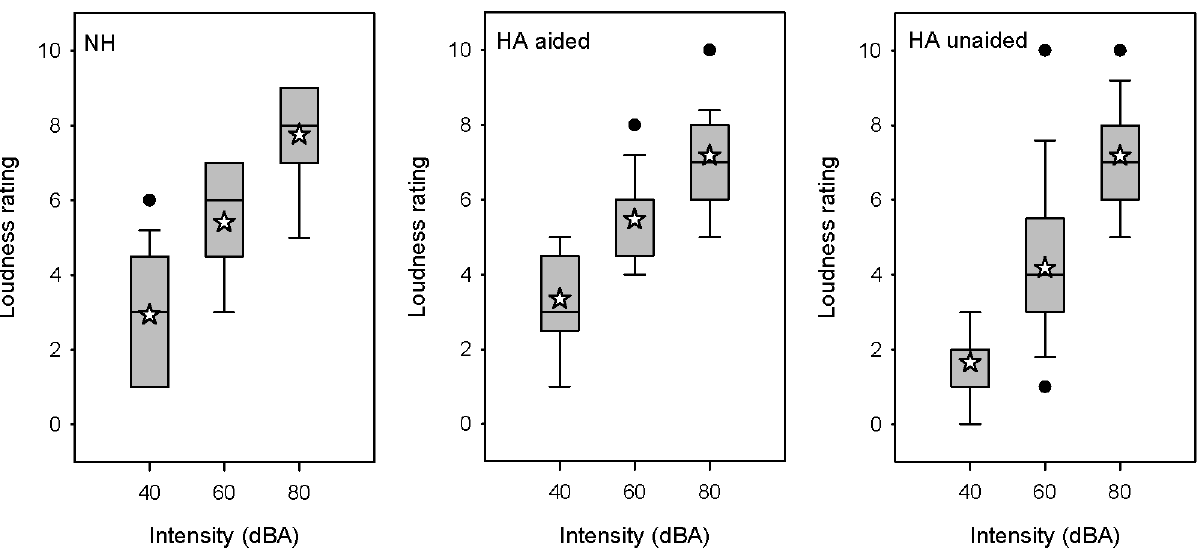
Figure 2. Boxplots of loudness ratings for 1-kHz tone bursts at 40, 60, or 80 dBA for the NH group, the HA group ( aided ), and the HA group ( unaided ). The boxes show the 25th and 75th percentiles, the error bars show the 10th and 90th percentiles, the filled circles show outliers, the horizontal lines show the median, and the white stars show the mean.